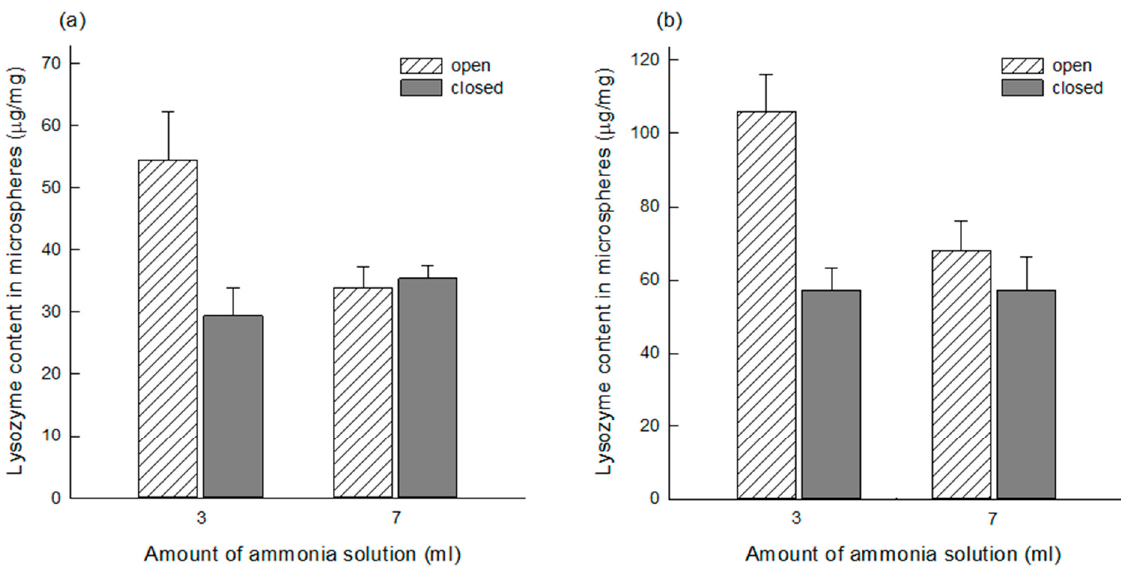
Figure 8. Comparison of lysozyme payloads in porous microspheres before and after pore closure. Wet microspheres prepared using 3 mL and 7 mL of the ammonia solution were equilibrated at RT for 2 h in ( a ) 50 mg/mL and ( b ) 100 mg/mL lysozyme solutions containing 0.2% Tween 80, which was further subjected to self-healing. Lysozyme contents in the microspheres were determined before and after self-healing.